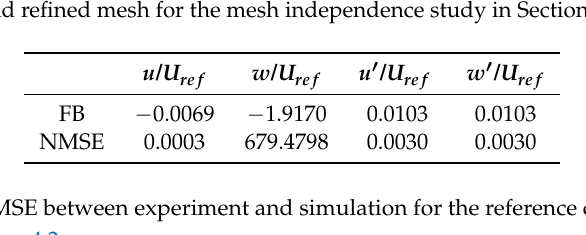
Table A1. Fractional bias (FB) and normalized mean-square error (NMSE) between the simulations with default mesh and refined mesh for the mesh independence study in Section 4.2.